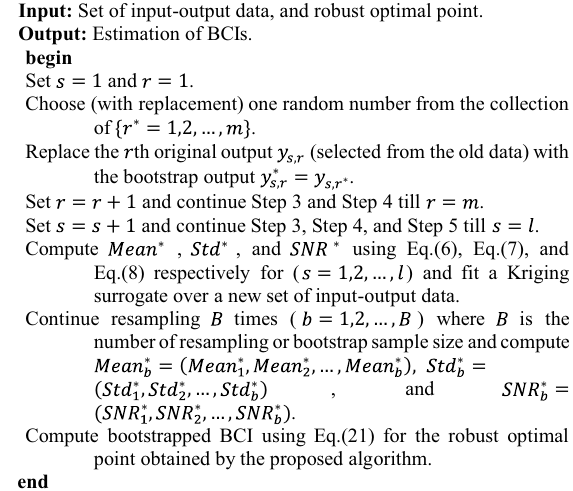
Algorithm 3 The augmented bootstrapping